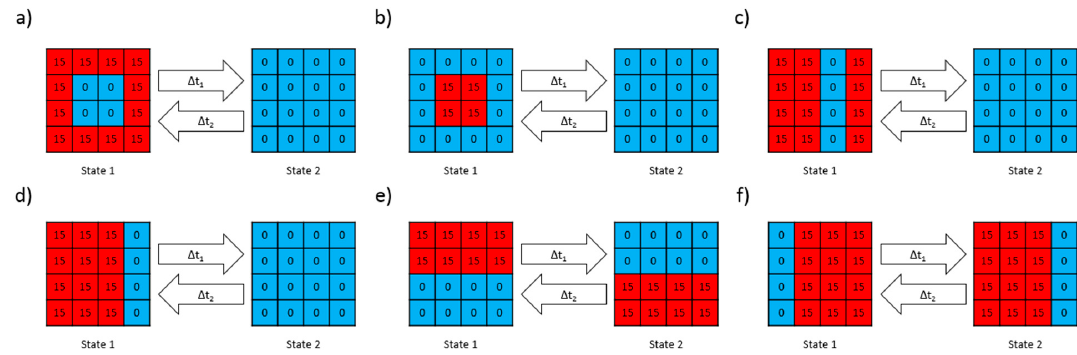
Figure 6. Microelectrode array actuation strategies. ( a ) The scheme for creating middle focusing potential ( control scheme A); ( b ) the scheme for the middle defocusing potential generation (control scheme B); ( c ) the translation to the 3rd column scheme (control scheme C); ( d ) the translation to the 4th column scheme (control scheme D); ( e ) the “horizontal” midline deposition (“squeezing”) scheme (control scheme E); ( f ) the “horizontal” stretching scheme (control scheme F). Each grid cell corresponds to a single electrode in the microelectrode array, as shown in Figure 3 and in the upper right corner of Figure 5.